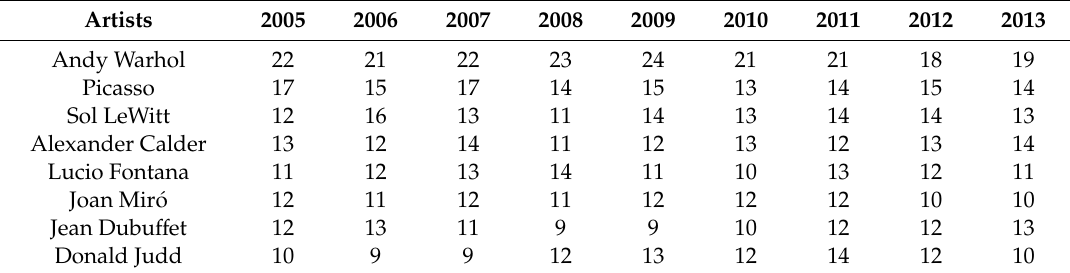
Table 4. Artists included in at least 10 rosters of the stable galleries (included for nine years).